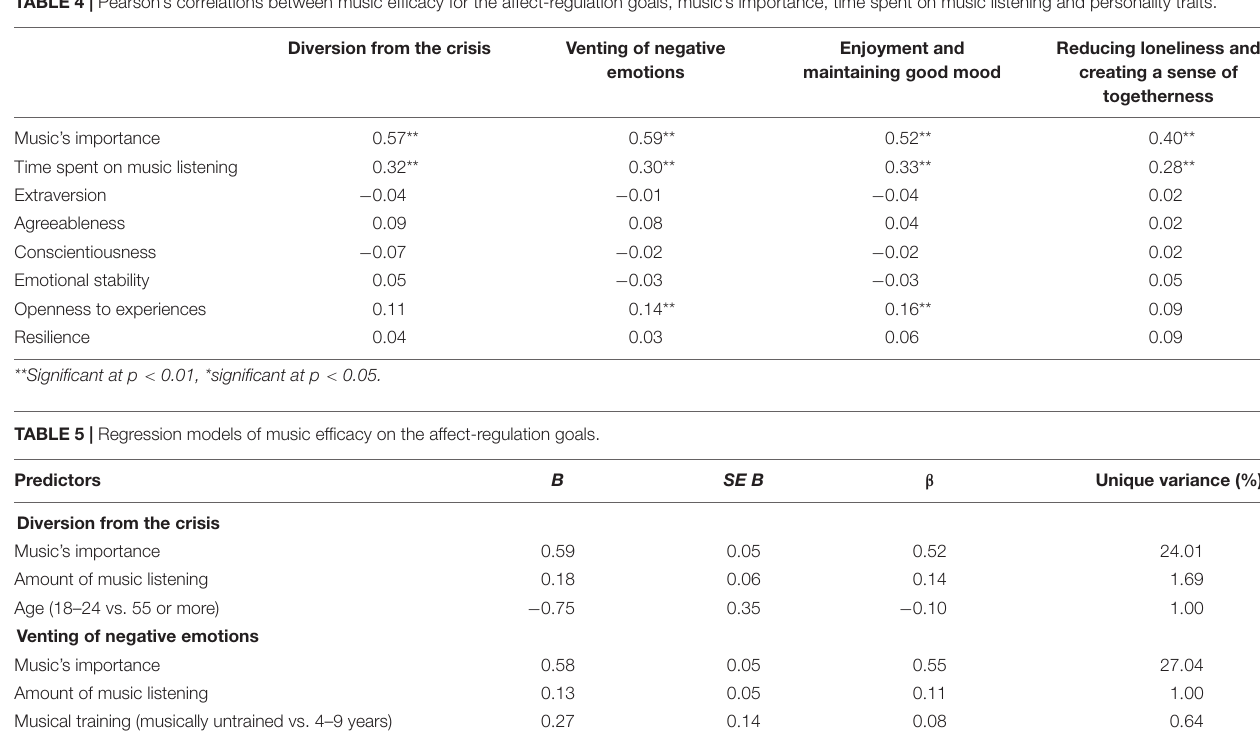
TABLE 4 | Pearson’s correlations between music efficacy for the affect-regulation goals, music’s importance, time spent on music listening and personality traits.